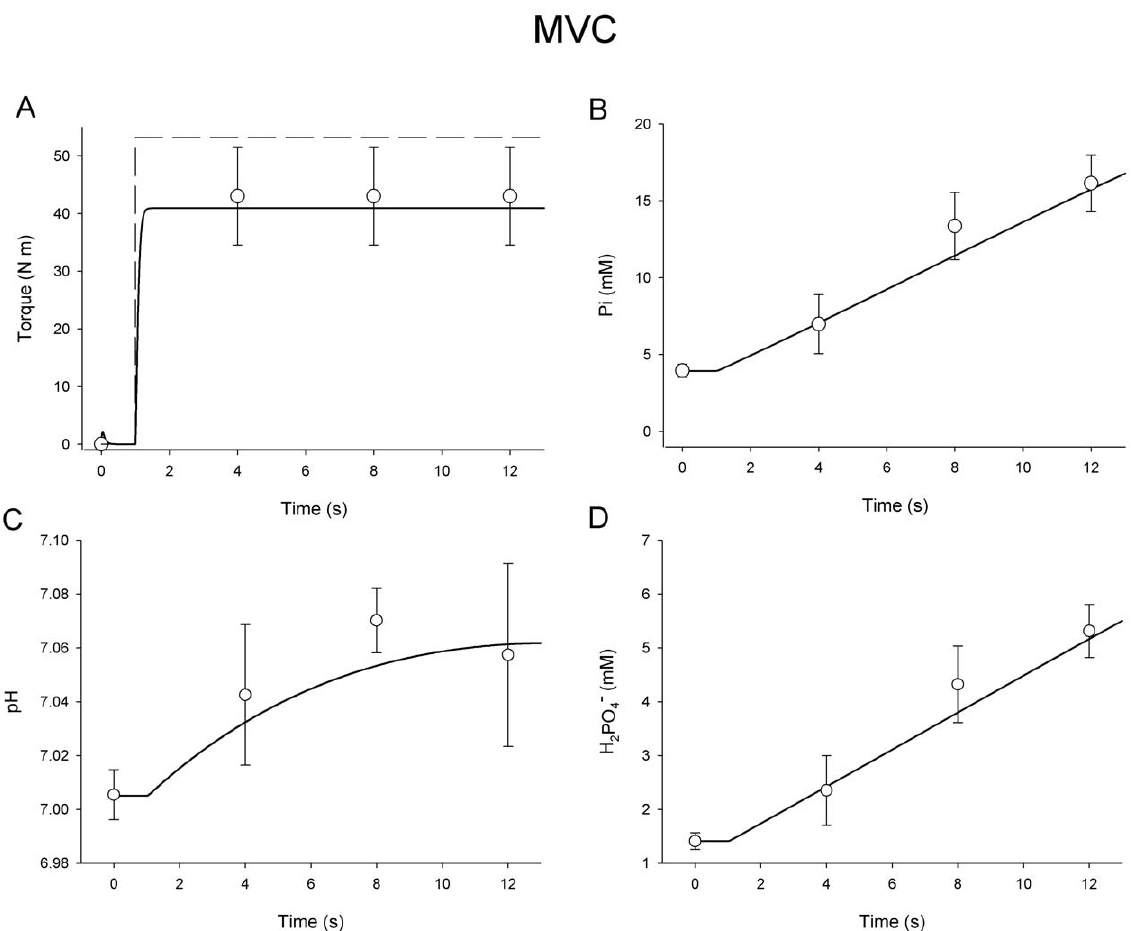
Figure 5. Simulated Maximum Voluntary Contraction. A: Simulated torque during 12-s MVC in thin black line with experimental data (open symbols 6 SD). Blue line is the target torque (T t ) for the model to approximate. It was set to increase from zero to 110% of expected peak torque output to ensure full activation at t=1 s. B: Simulated (black line) and experimental (open symbols 6 SD) inorganic phosphate concentration (mM) during 12-s maximum voluntary contraction. C: Simulated (black line) and experimental (open symbols 6 SD) pH during 12-s maximum voluntary contraction. D: Simulated (black line) and experimental (open symbols 6 SD) H 2 PO 4- during 12-s maximum voluntary contraction.